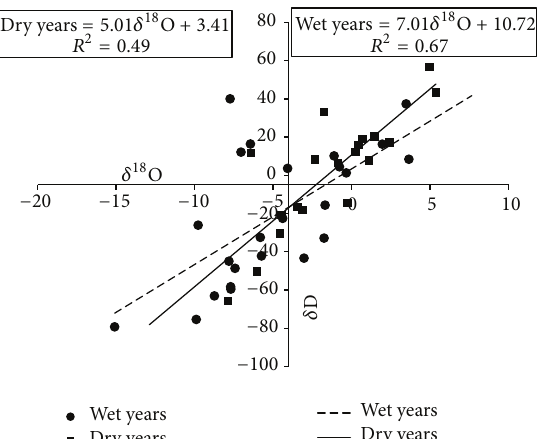
Figure 11: Monthly weighted means of 𝛿 D and 1 𝛿 18 O relationships for dry and wet years.